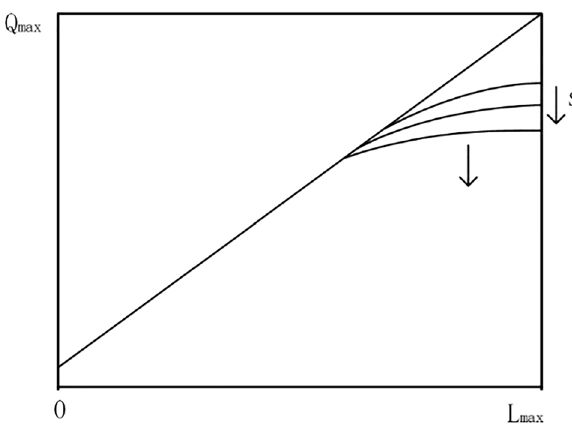
Figure 5. Flow characteristic curve of valve.